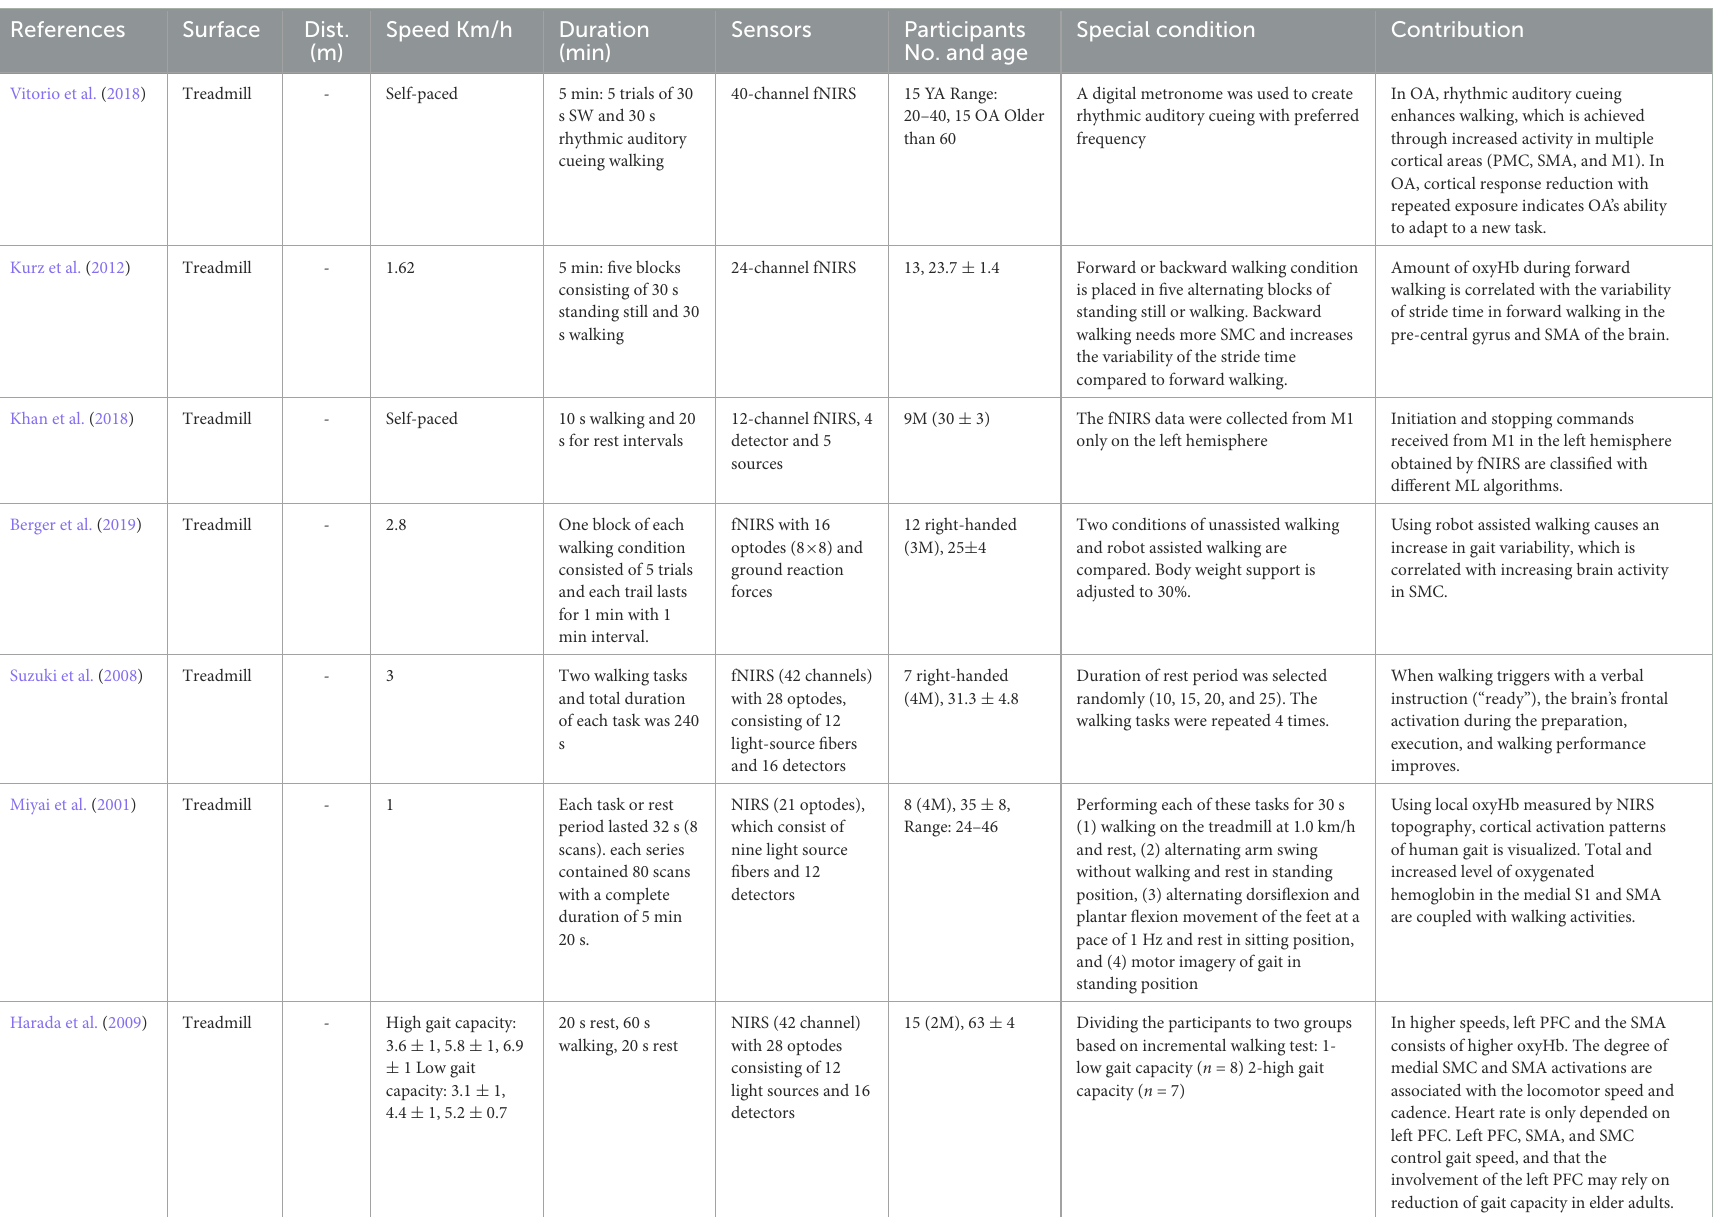
TABLE 2 Brain-body imaging in